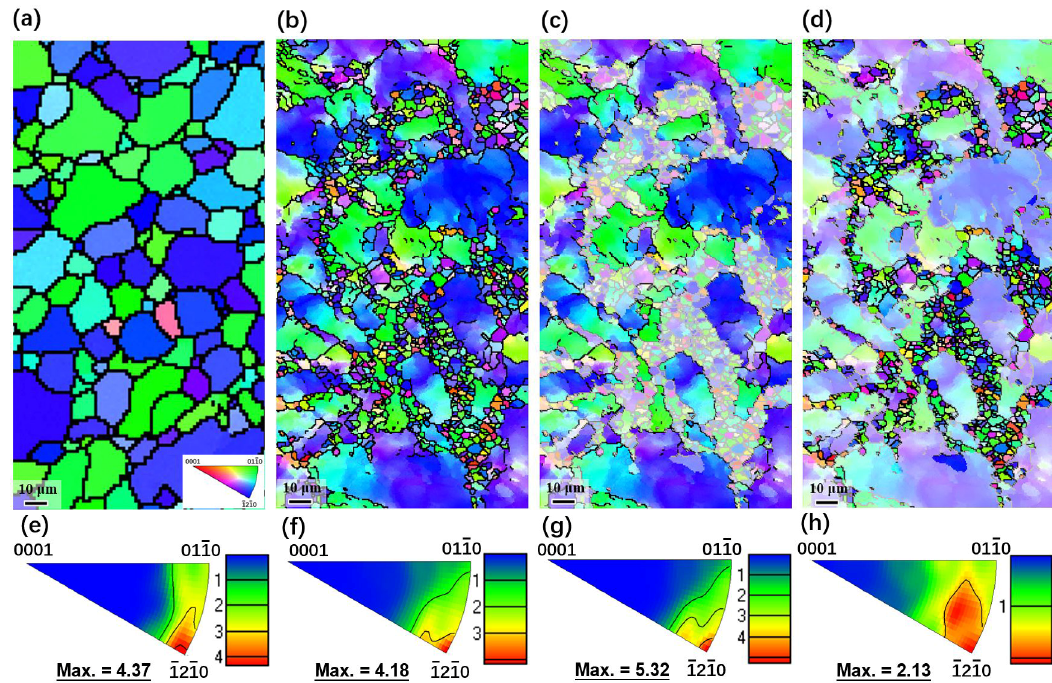
Figure 6. ( a – d ) Inverse pole figure (IPF) maps and ( e – h ) IPFs of ( a , e ) as-extruded and ( b – d , f – h ) caliber-rolled (Cred) AB83 alloy; ( b , f ) overall, ( c , g ) undynamic recrystallized (unDRXed) and ( d , h ) DRXed regions of the CRed AB83 alloy.